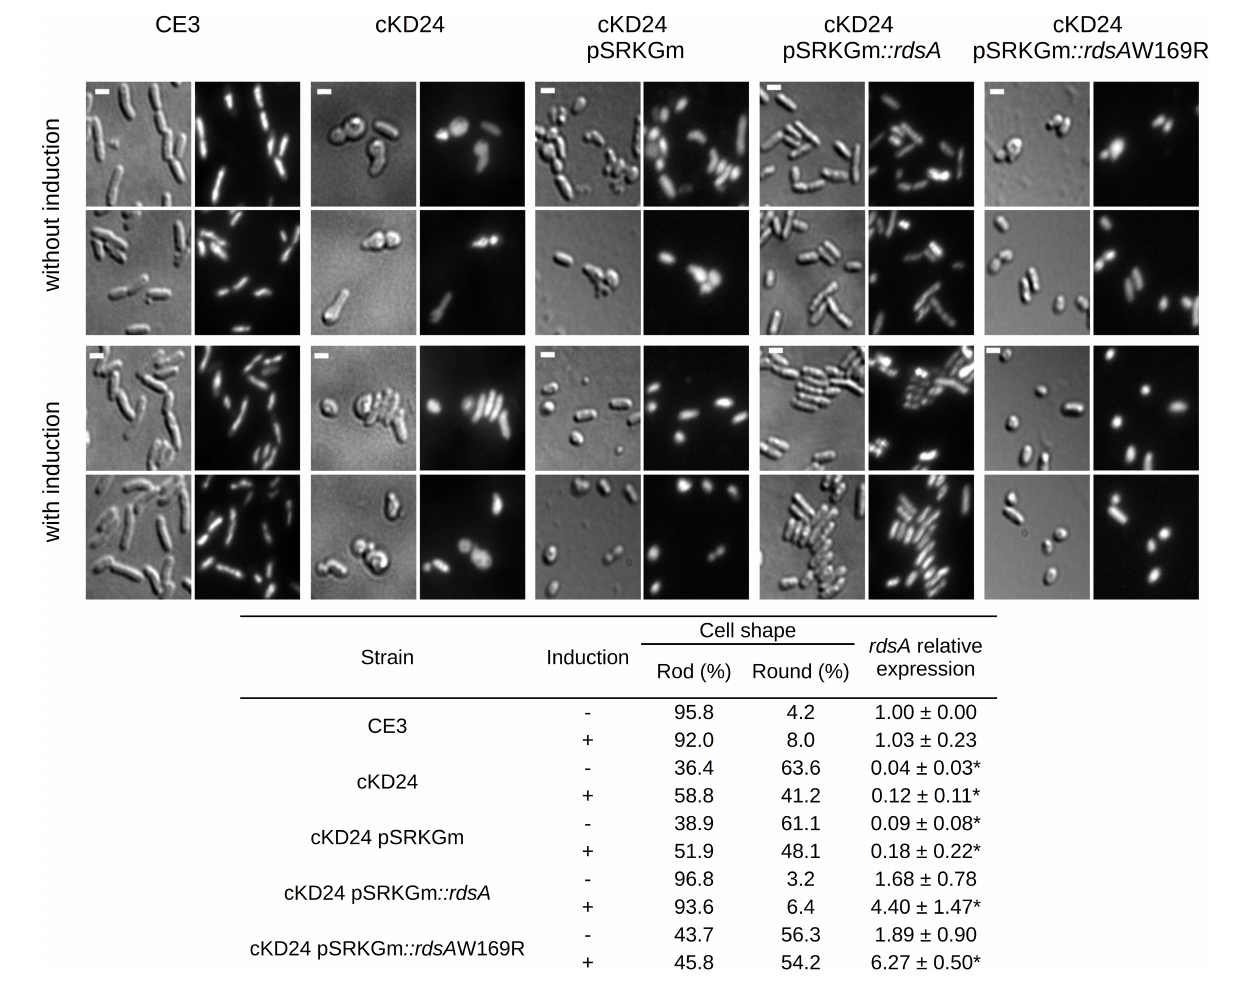
FIGURE 1 | Depletion of RdsA causes a change in cell shape. The top part shows the microscopic analysis of uninduced (top two rows) or induced cells (bottom two rows) for different strains. CE3 ( R. etli wild type), RdsA depleted strains (cKD24, cKD24 pSRKGm) or complemented strains (cKD24 pSRKGm :rdsA , cKD24 pSRKGm :rdsA W169R). After growth in liquid PY media for 10 h without or with induction, cells were spotted on a 1% agar pad. Each light background image (DIC images) has a corresponding image using DAPI staining (dark background). Scale bar, 1.5 µ m. The table at the bottom of the figure shows the percentage of cells with a rod or round shape. Percentages were obtained by counting at least 900 cells for each strain/condition through three independent biological replicas. The table also shows rdsA relative expression obtained by RT-qPCR, after normalization with the rpoA constitutive gene. Data are means ( ± SD) obtained from three independent biological replicates (each with three experimental replicates) for every treatment. Statistically significant differences between R. etli CE3 RQ and the five cKD24 mutant strain RQ levels are marked with asterisks, and were evaluated with a Student’s t -test ( P <